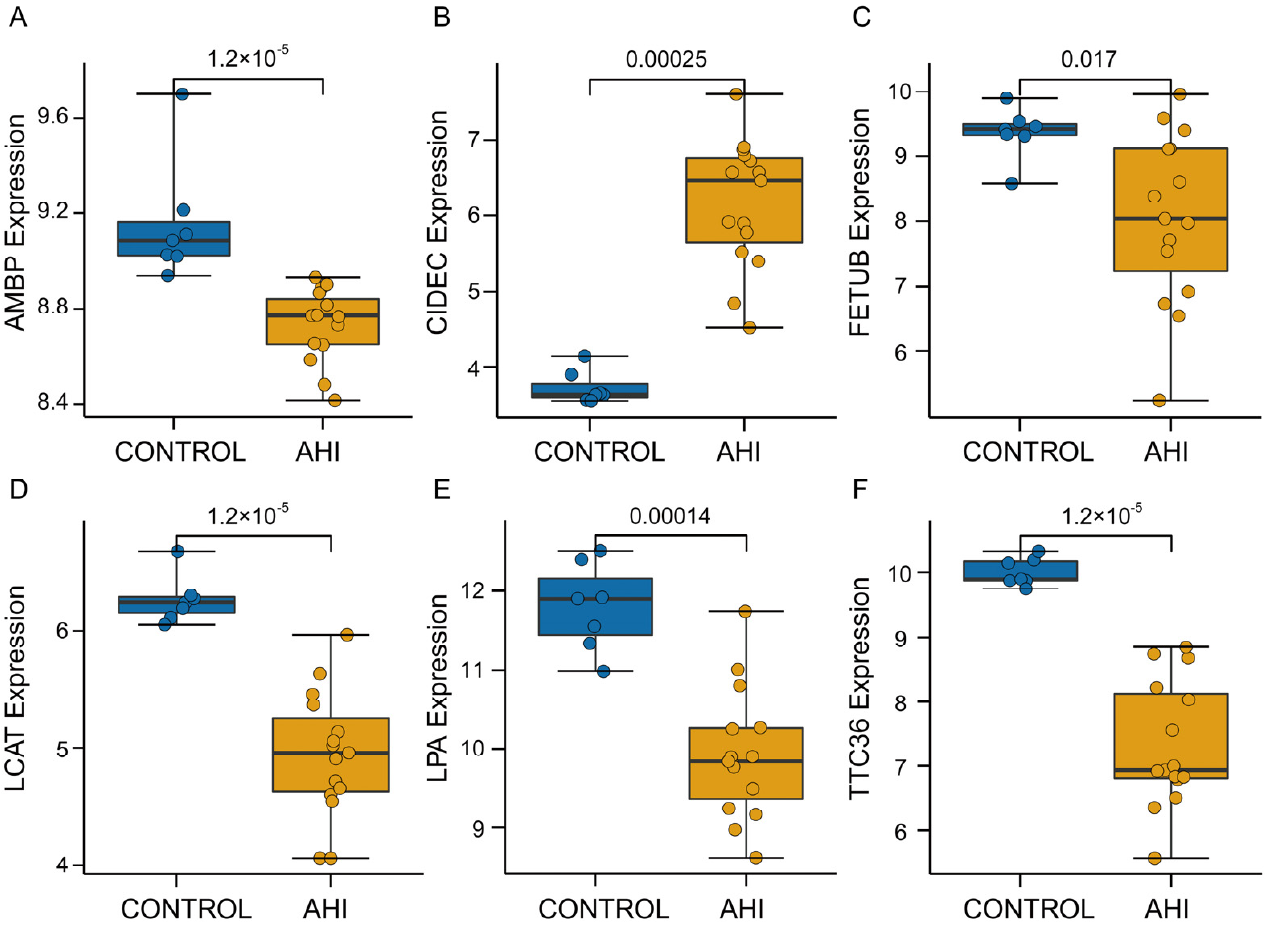
Figure 4. Validation of hub genes. ( A ) AMBP , ( B ) CIDEC , ( C ) FETUB , ( D ) LCAT , ( E ) LPA, and ( F ) TTC36.